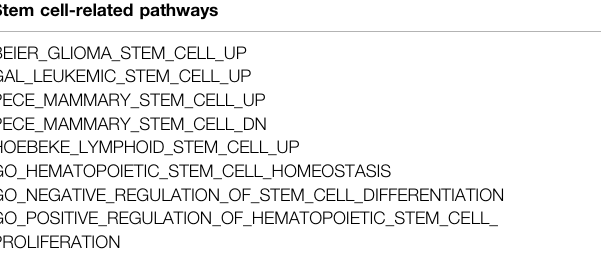
TABLE 3 | Stemness-related high-risk genes affect stem cell-related pathways. Stem cell-related